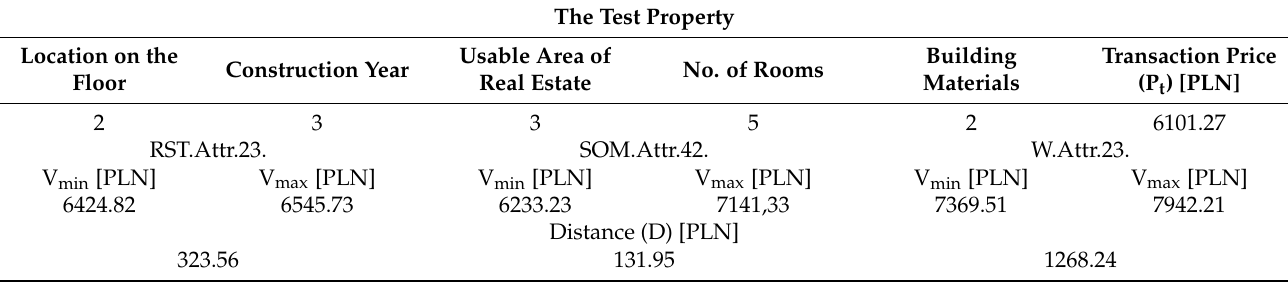
Table 8. Range of distances between the transaction price for the benchmark property no. 32 and the value range, illustrated using an example homogenous area. Source: own elaboration. The Test Property